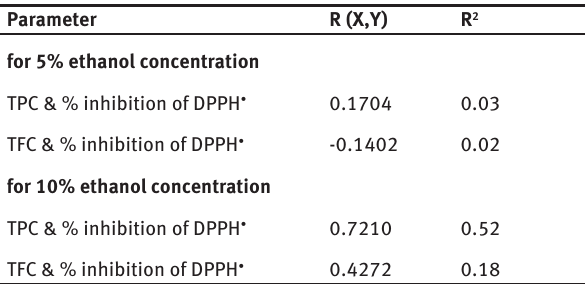
Table 9: Pearson correlation coefficients R(X, Y) and coefficient of determination (R 2 ) showing relationship between TPC, TFC and % inhibition of DPPH • for Tilia L. extracts (Tilia